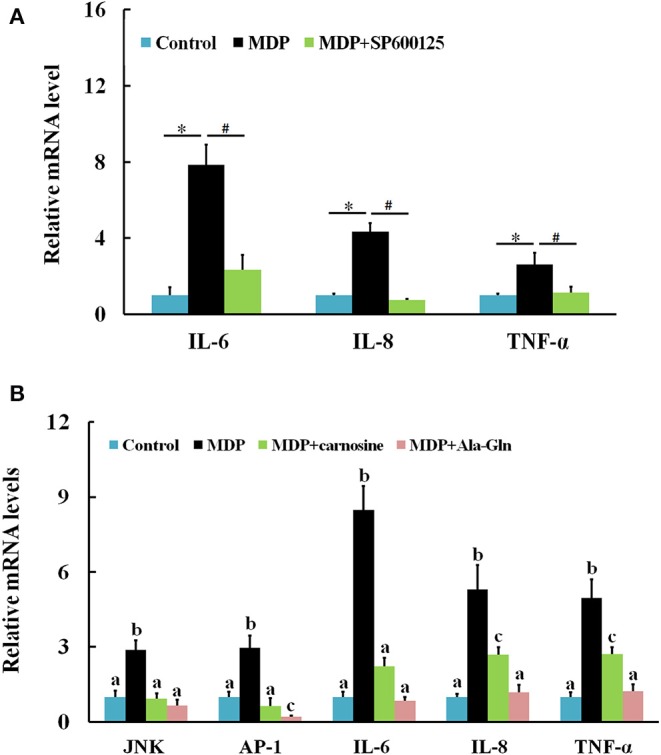
Relative expression of intestinal inflammatory cytokines and CiJNK/CiAP-1 pathway genes in response to MDP challenge. (A) Grass carp were injected with MDP in the presence or absence of the JNK inhibitor SP600125. Significant differences are indicated by * or # (P < 0.05). (B) Grass carp were challenged by PBS, MDP, MDP + carnosine, or MDP + Ala–Gln. The β-actin gene was used as a reference gene to normalize the expression level. Each bar represents the mean of the normalized expression levels of replicates (N = 3). Data without shared letters were significantly different (P < 0.05).